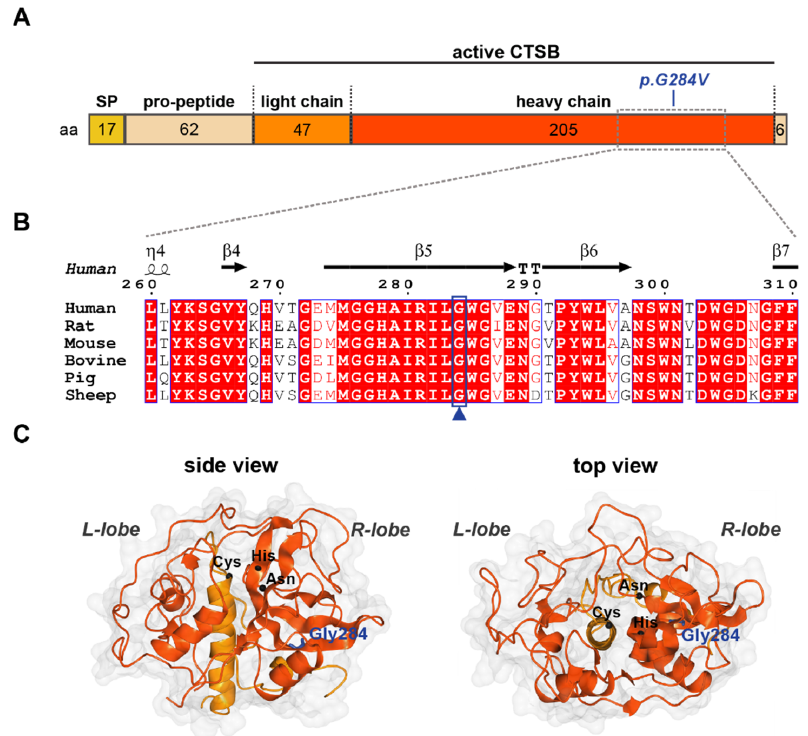
Figure 2. Flowchart of genetic experiments conducted on the typical PD family. EOPD = early onset Parkinson’s disease, MAF = minor allele frequency, MLPA—Multiplex ligation-dependent probe amplification.